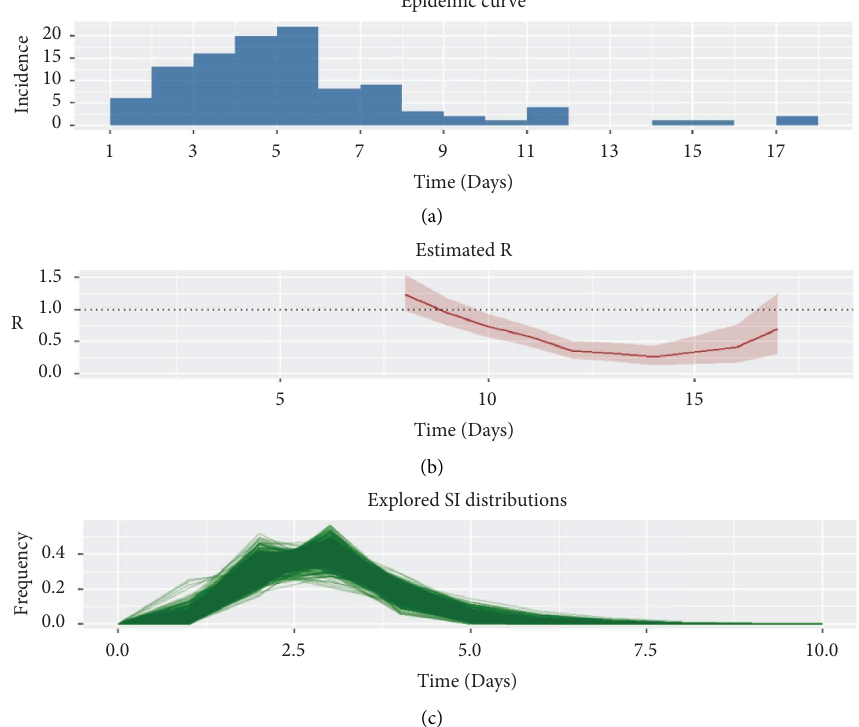
Figure 1: Transmissibility assessment of SARS-CoV-2 Omicron variant in Beichen district, Tianjin, China. (a) Epidemic curve of reported confrmed cases ( n � 108). (b) Te time-dependent reproduction number (95% CI) of Omicron variant. (Using the Markov Chain Monte Carlo method and for 7-day timelapse on moving average data). (c) Te distribution of serial interval of Omicron